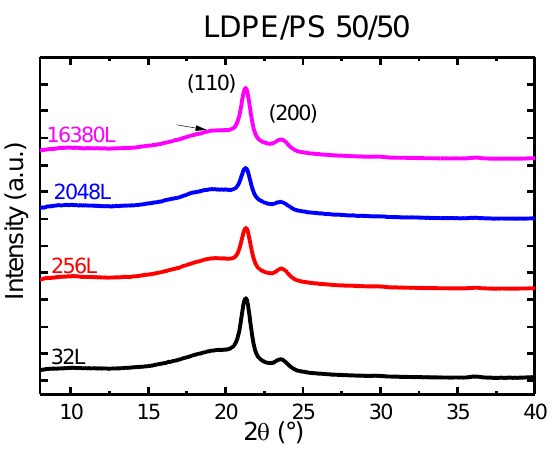
Figure A4. 1D-WAXS profiles for LDPE/PS multilayers with different numbers of layers: 32L, 256L, 2048L and 16380L. The intensity was normalized with the thickness of the studied films. The scattering angle was denoted 2θ.